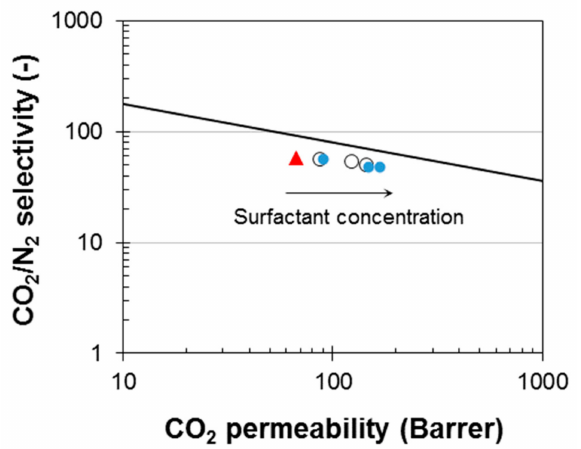
Figure 7. Robeson’s plot for the CO 2 / N 2 pair showing the data of the prepared membranes. Red triangle (neat Pebax ® 1657); open circles (Pebax / T20); closed circles (Pebax / T80). The black line represents